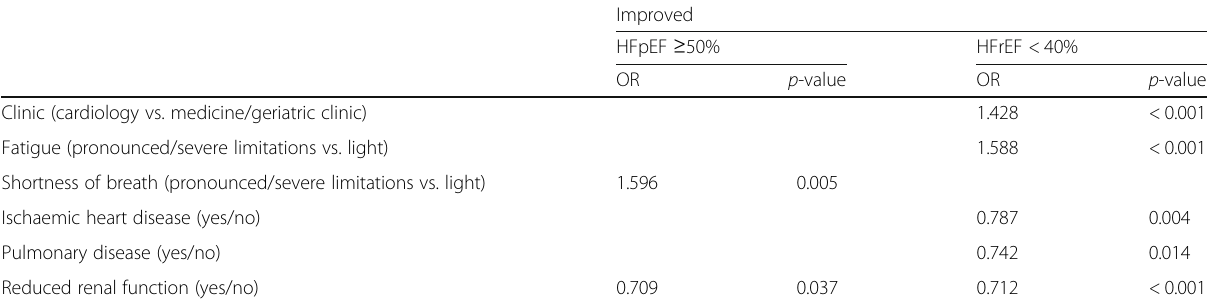
Table 3 Results from multiple logistic regression analysis with Odds Ratios (OR) of factors affecting improved outcomes in the two groups HFpEF and HFrEF